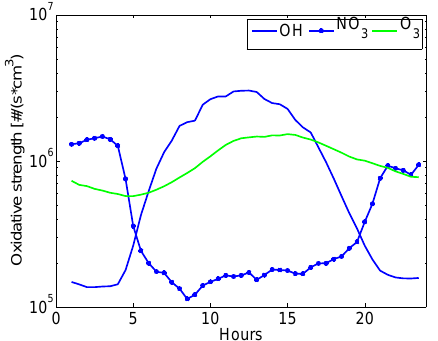
Figure 15. The daily averaged oxidation strength (see Sect. 7.4.5 for definition) of OH (blue line), O 3 (green line) and NO 3 (blue dotted line) at 18m. Please note the log scale on the y